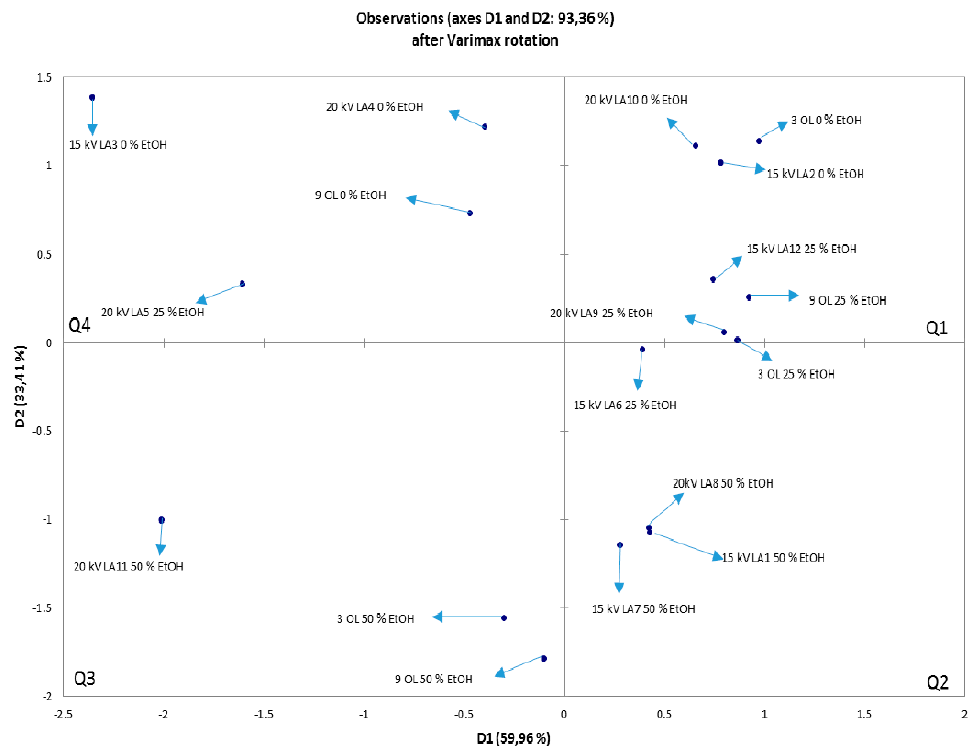
Figure 7. The PCA of untreated and HVED treated samples. The data is denoting untreated OLEs (CE), and OLEs treated with HVED using argon. Q stands for quadrant.